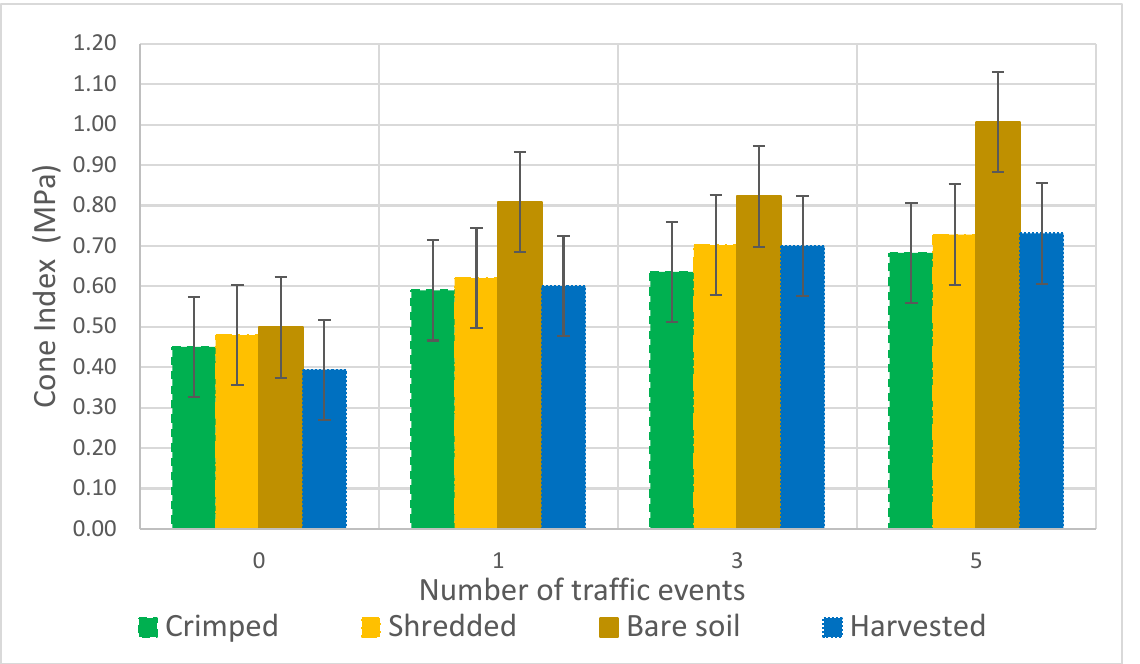
Figure 6. Cone index means after different numbers of traffic events and cover crop mulch treatments (Harvested; Bare soil; Crimped; Shredded). Residual standard errors were used on bar error.